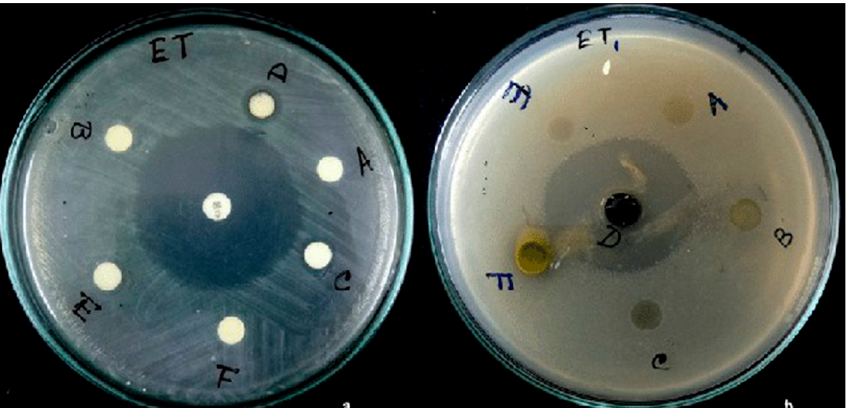
Figure 8. Inhibition of Edwardsiella tarda by ( a ) agar disc diffusion and ( b ) agar overlay well diffusion assays. A: aqueous control; B: aqueous test; C: chloroform control; D: chloroform test; E: methanol control; F: methanol test; C 30: chloramphenicol, 30 µg/disc; 10 µL/disc and 50 µL/well used for agar disc diffusion and agar overlay well diffusion assays, respectively. Figure and caption reused from Purkait et al. [88]. Used under the Creative Commons License (http://creativecommons.org/licenses/by/4.0/ (accessed on 26 February 2021)).